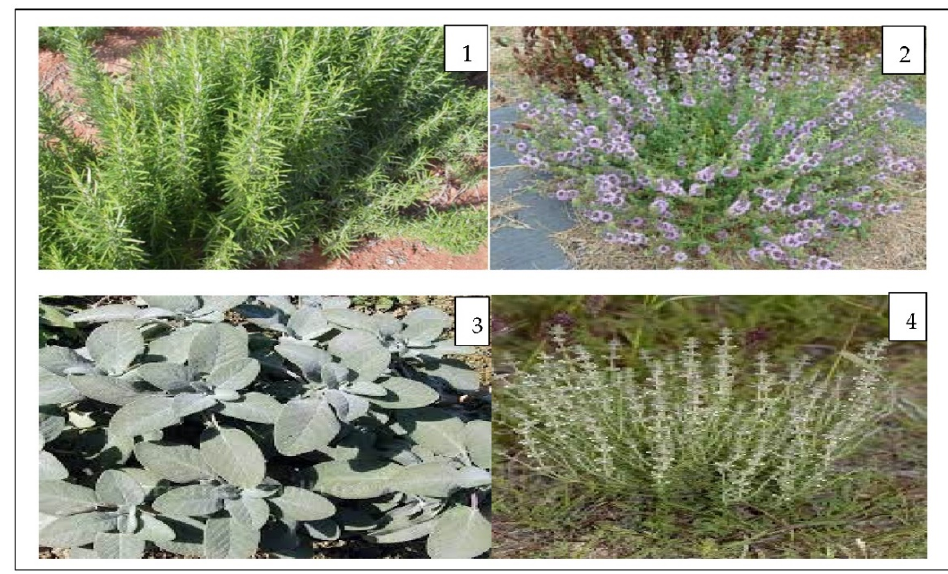
Figure 1. Plants used in our study, R. officinalis (1), M. pulegium (2), S. officinalis (3), and T. Zygis (4).